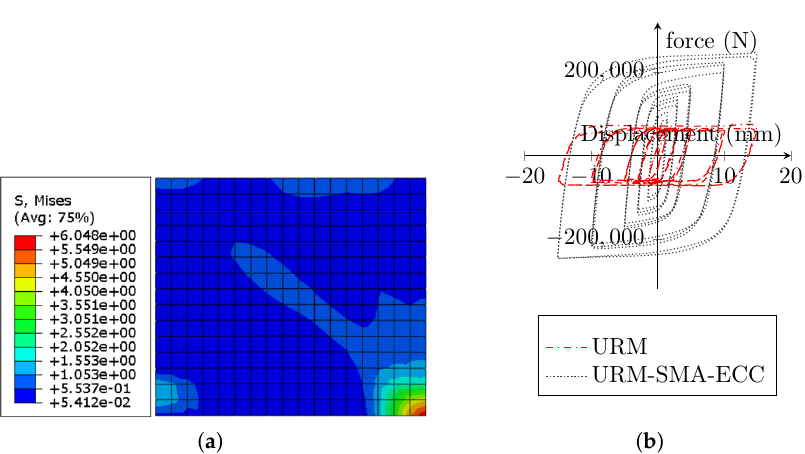
Figure 21. ( a ) Stress distribution in the masonry wall used in the URM-SMA-ECC system; ( b ) hys- teresis of the masonry wall.